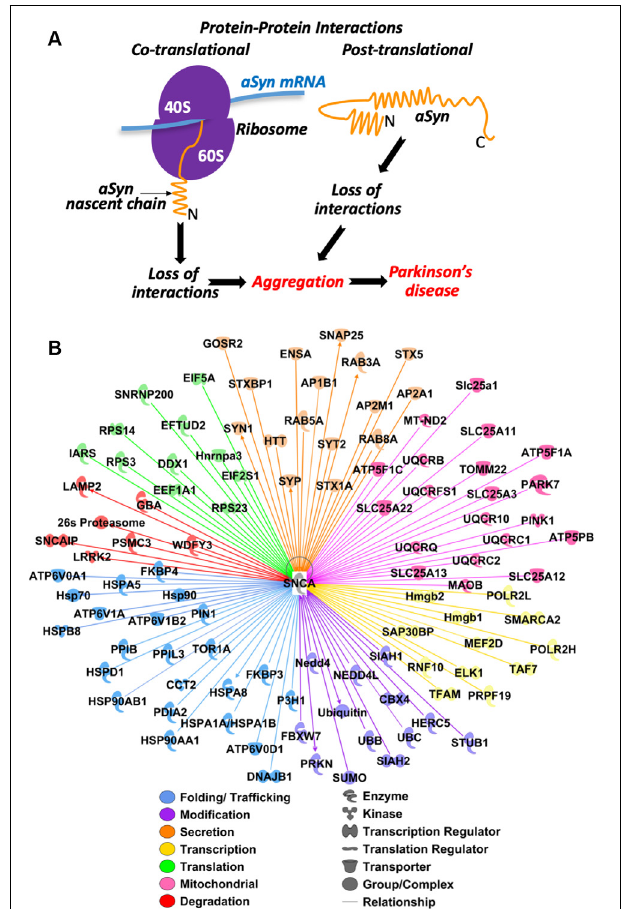
FIGURE 2 | Predicted protein-protein interactions in aSyn pathology: hypothesis and bioinformatic analysis. (A) Conceptual model of aSyn pathology induced by loss of co-translational and post-translational interactions due to mutations in aSyn or omission of partners. (B) Prediction of aSyn protein-protein interaction during biogenesis. Ingenuity Pathway Analysis (IPA) software (Qiagen) was used to analyze possible aSyn interactions and pathways. aSyn gene SNCA was selected as the primary molecule (shown in the center). The initial analysis revealed 474 interacting proteins. The pathway was trimmed to only show proteins that are complexes, enzymes, kinases, phosphatases, groups, transcription regulators, translation regulators, transmembrane receptors, or transporters. Two-hundred and seventy-eight interacting proteins remained and were filtered based on their major functions. Functions examined are those involved in transcription (yellow), translation (green) folding/trafficking (blue), modification (purple), secretion (orange), mitochondrial (pink), and degradation (red). One-hundred and two interacting proteins remained. All filtering was done to specifically analyze the protein-protein interactions involved in aSyn